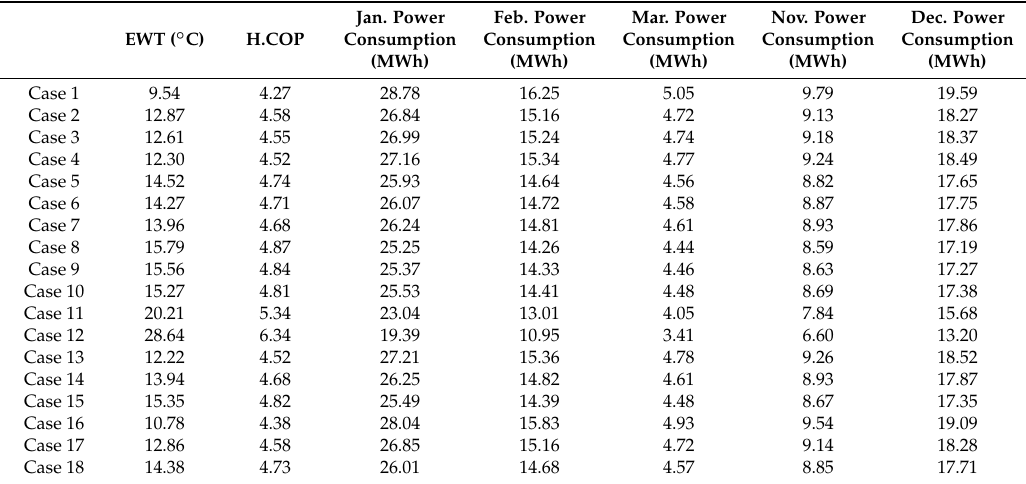
Table 9. EWT, H.COP and monthly power consumption of each case.